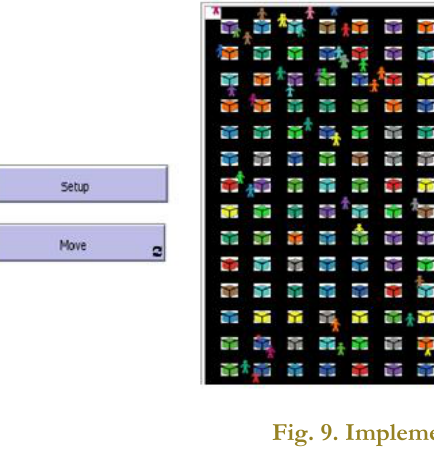
Fig. 9. Implement